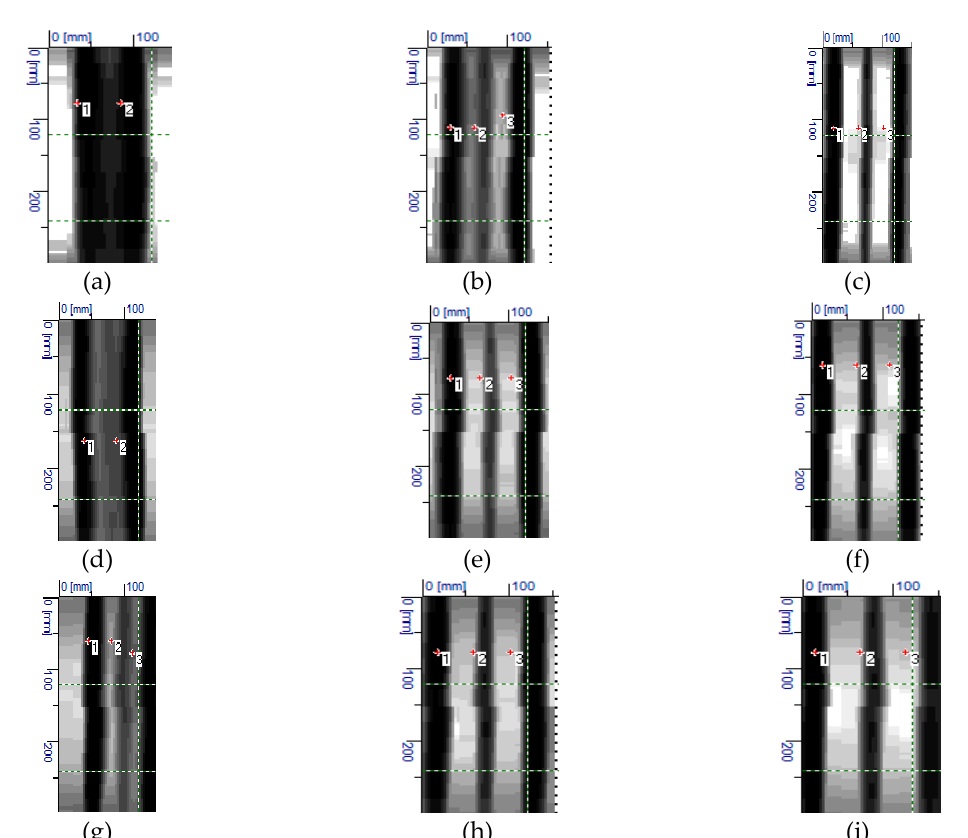
Figure 18. Results from tests conducted with the electromagnetic device (1): ( a ) S-10-20 (result: